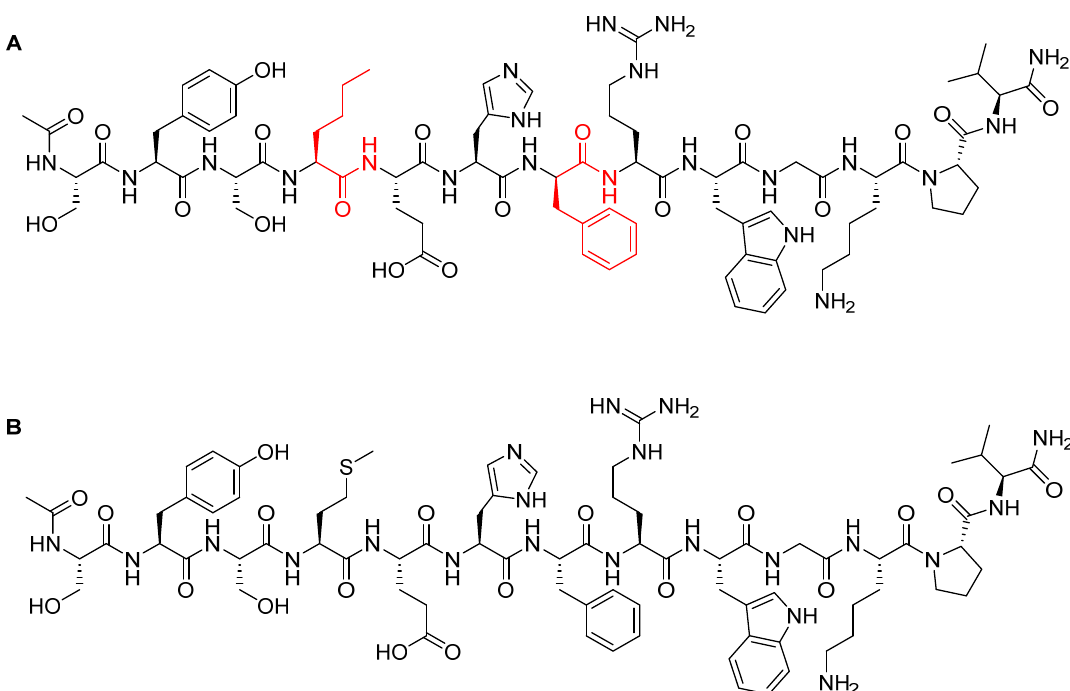
Figure 5. Chemical structure of: ( A ) Afamelanotide (Scenesse TM ); ( B ) α -melanocyte stimulating hormone ( α -MSH). Differences are shown in red.